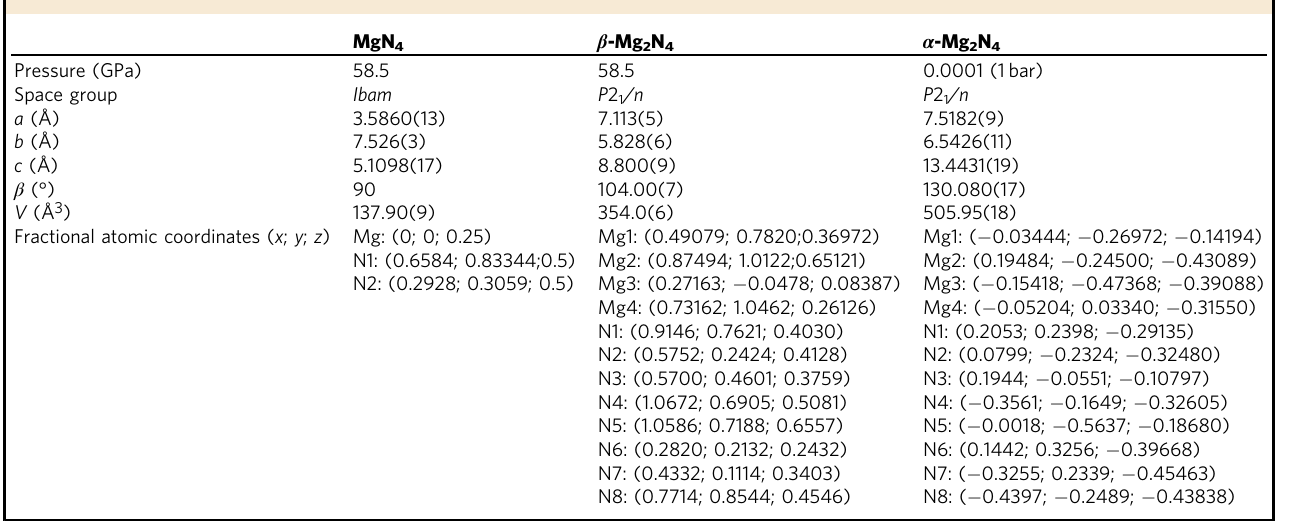
Table 1 Crystallographic data for the MgN 4 , β -Mg 2 N 4 and α -Mg 2 N 4